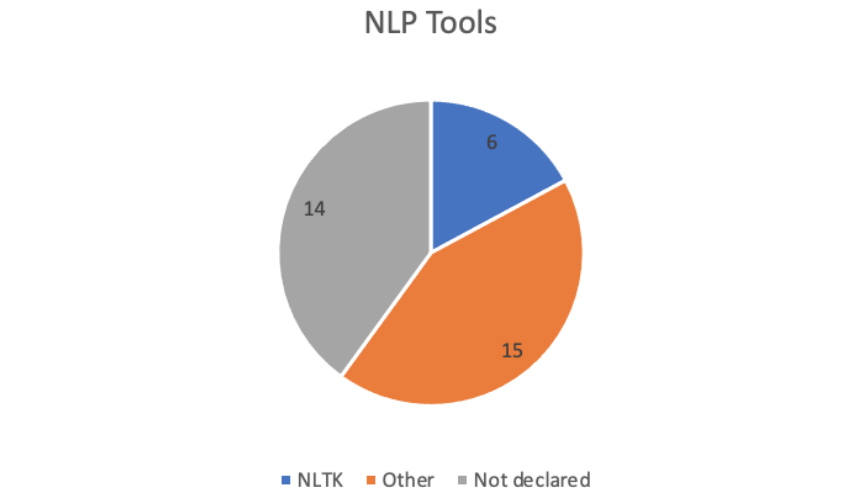
Figure 5. A chart showing a summary of the different types of NLP tools in each